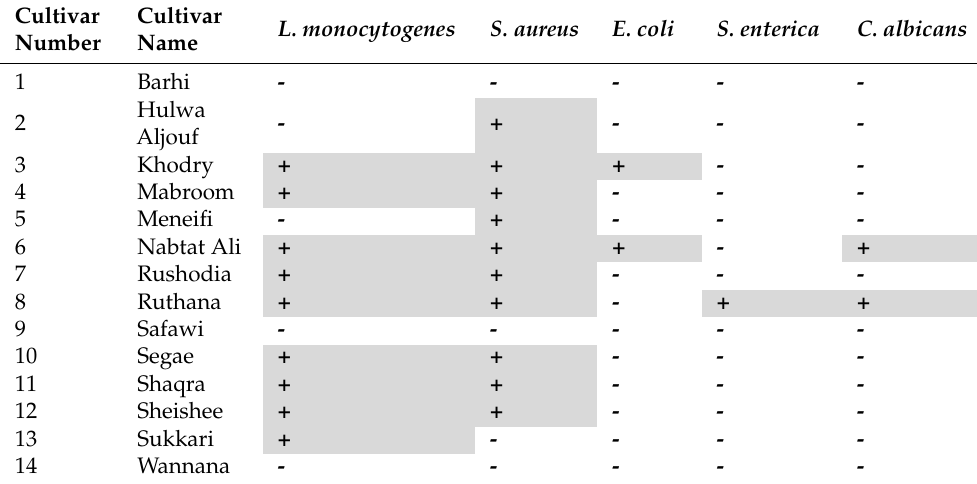
Table 1. Antimicrobial activity of fourteen date pit extracts against different indicator